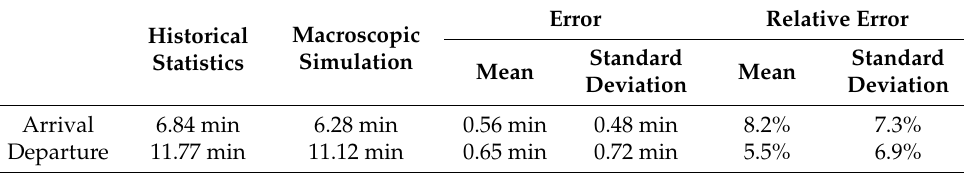
Figure 9. Calibration of apron congestion cost. ( a ) Apron sectorization. ( b ) The relationship between apron delay and traffic movements in each apron area. Table 3. Accuracy evaluation of congestion cost parameters calibration based on aggregated taxiing